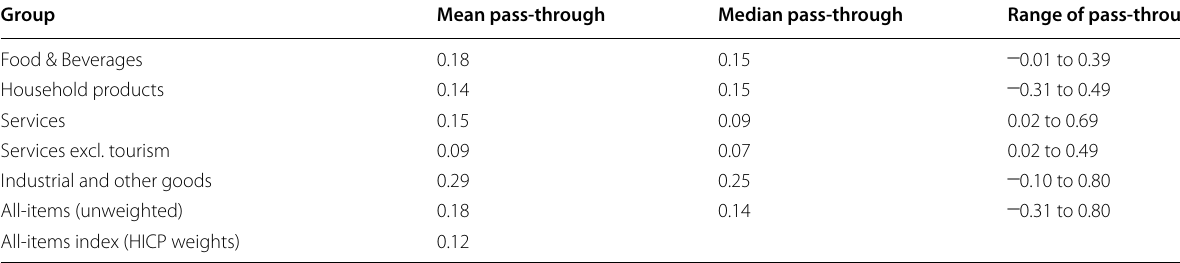
1-year pass-through of the 2015 EUR/CHF shock to Swiss consumer prices implied by the synthetic DID method of Arkhangelsky et al. (2021). Pass-through is computed from the DID coefficients using Eq. 4. Regressions use the HICP consumer price data with pre-treatment from January 2014 to January 2015 and post- treatment from February 2015 to December 2015. Effect is estimated on Swiss prices using 33 European countries as a synthetic-weighted control group. The detailed group-level results are presented in Tables 5, 6, 7, and 8. The unweighted all-items index is a simple average over all categories of goods, and the weighted all-items index is the overall pass-through weighted by HICP weights, as computed by Eurostat